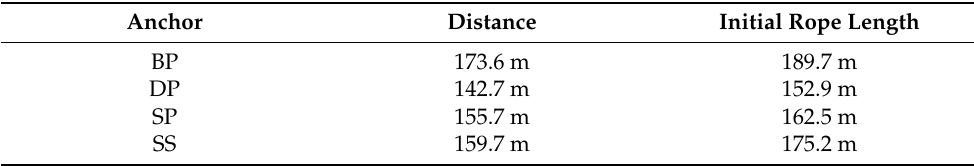
Table 4. Distance from the vessel and the initial ropes lengths.